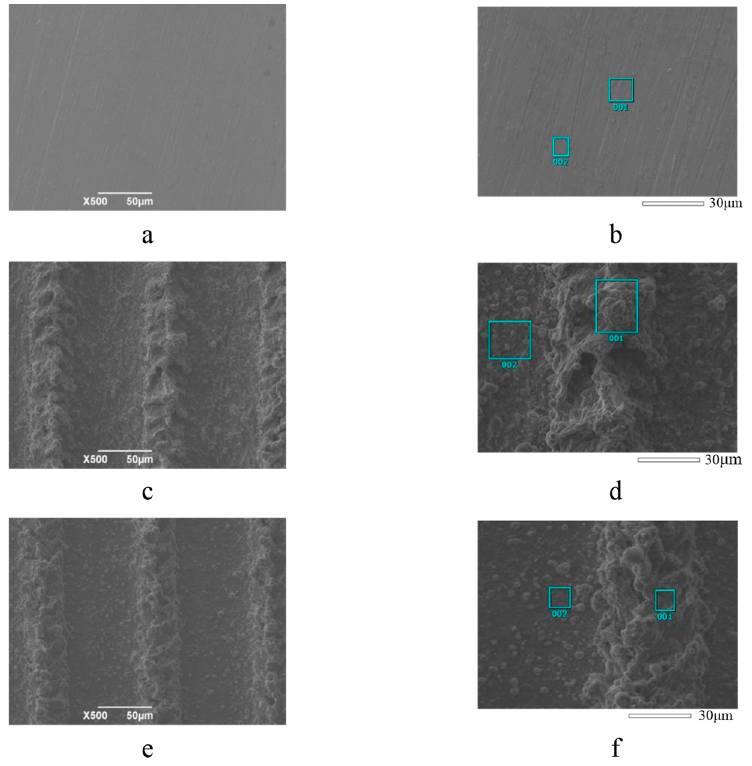
Figure 3. SEM of the samples used in the experiment: ( a , b ) the untreated surfaces, ( c , d ) the superhydrophilic surface and ( e , f ) the superhydrophobic surface.